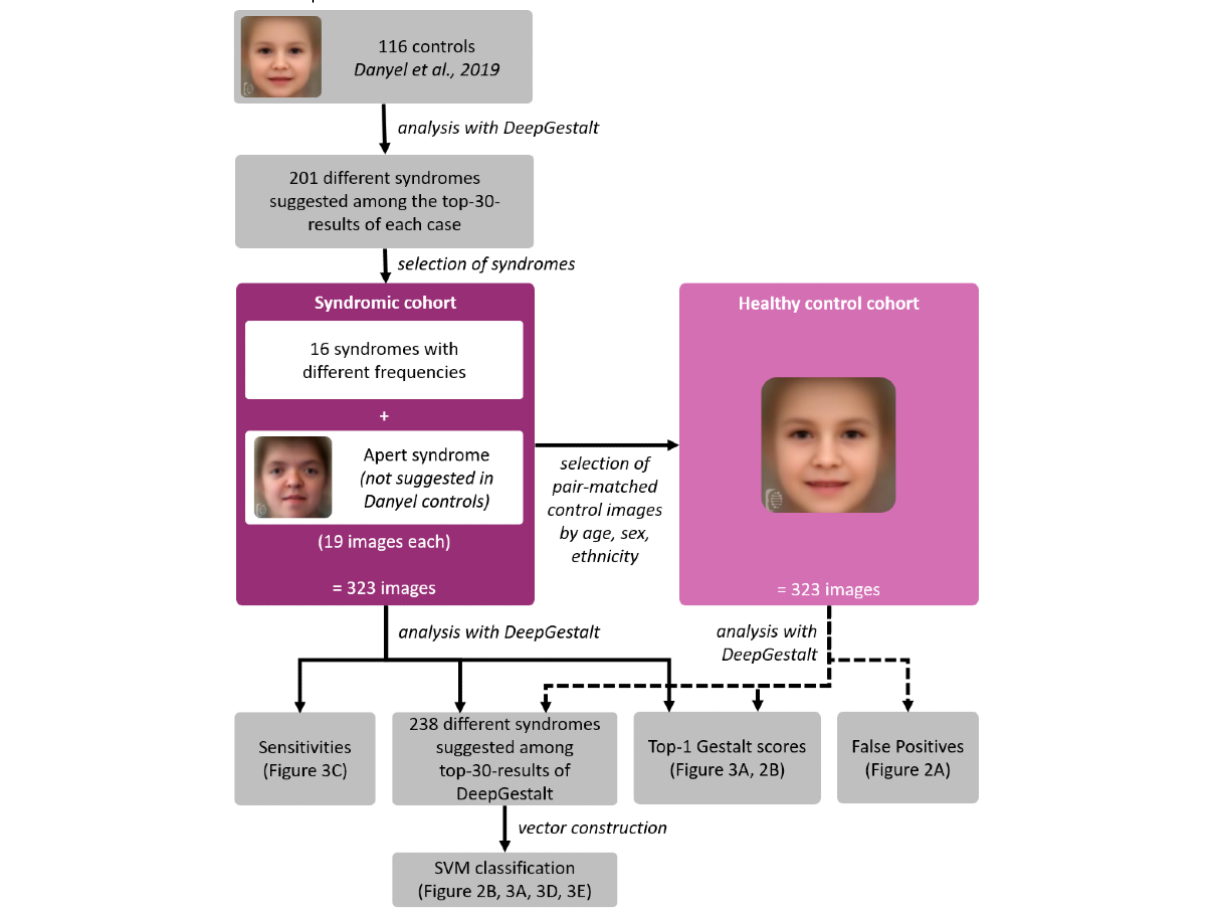
Figure 1. Workflow of classification